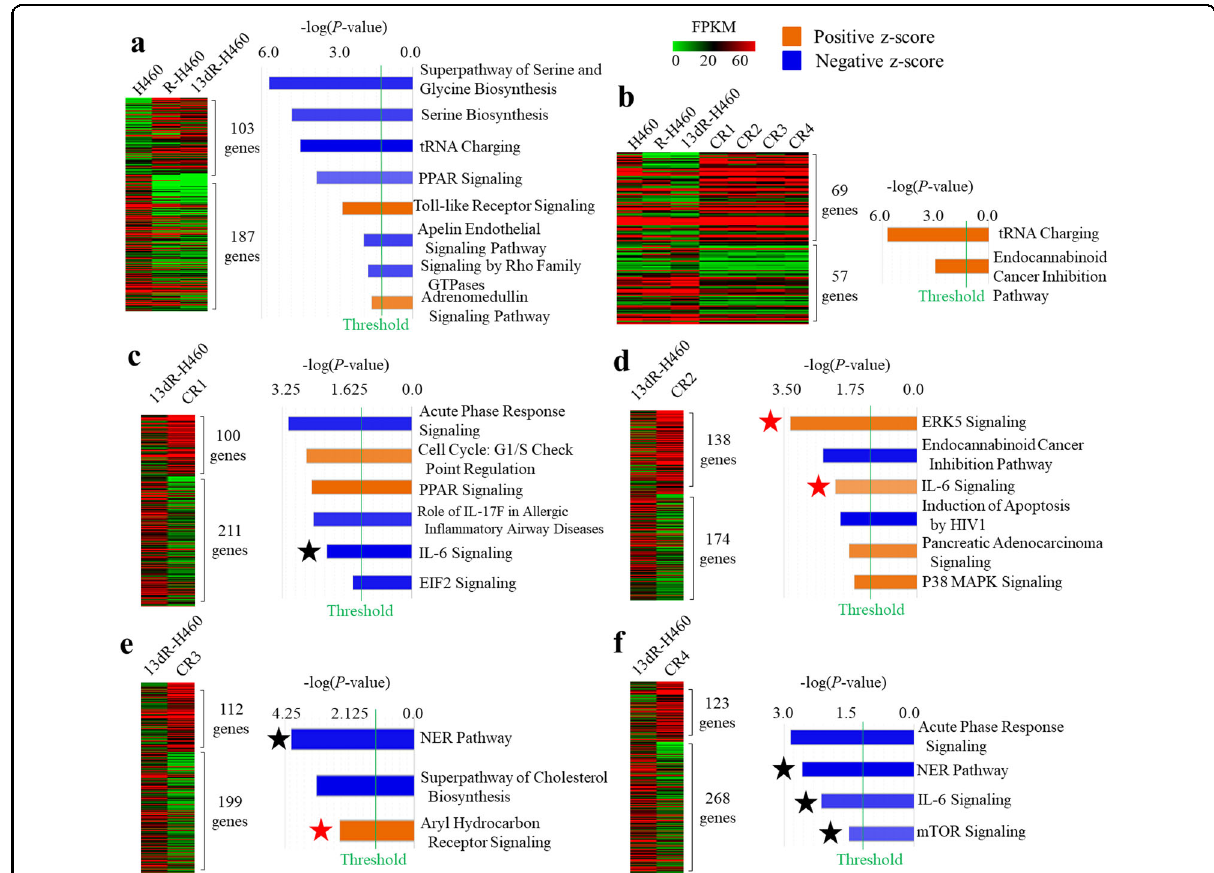
Fig. 4 Expression pro fi les of parental H460, R-H460, 13dR-H460, and CR 13dR-460 clones determined by RNA sequencing. a Differentially expressed genes (DEGs) in H460, R-H460, and 13dR-H460 cells and their main signaling pathways. The DEGs whose expression changed more than two-fold between H460 and 13dR-H460 are shown in a heatmap produced using the Multi-Experiment Viewer. The major pathways among the DEGs were analyzed by ingenuity pathway analysis. The pathways with absolute values of z-scores and a – log ( P -value) of at least 1.5 are shown. b Common DEGs and their main signaling pathways in CR clones (CR1-CR4) compared with 13dR-H460 cells. c DEGs speci fi c to CR1 and the main associated signaling pathways compared with 13dR-H460 ( d ) DEGs speci fi c to CR2. e DEGs speci fi c to CR3. f DEGs speci fi c to CR4. The orange- and blue-colored bars indicate predicted activation and inhibition, respectively. The red stars (Fig. 4c – f) indicate drug resistance-related signaling pathways whose levels increased in CR clones. The black stars (Fig. 4c – f) indicate drug resistance-related signaling pathways whose level was reduced in CR clones. FPKM scales for all fi gures are